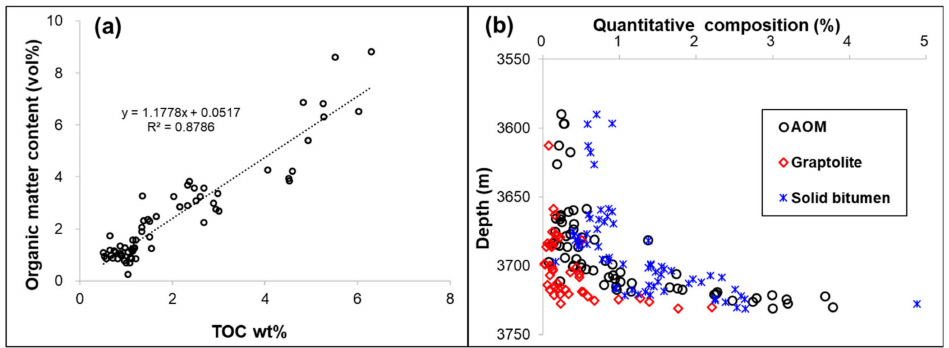
Figure 9. ( a ) The plots of TOC and organic matter content measured under microscope. ( b ) Quantita- tive organic matter composition varied with depth. Note: Quantitative composition = organic matter content × relative percentage of organic matter.